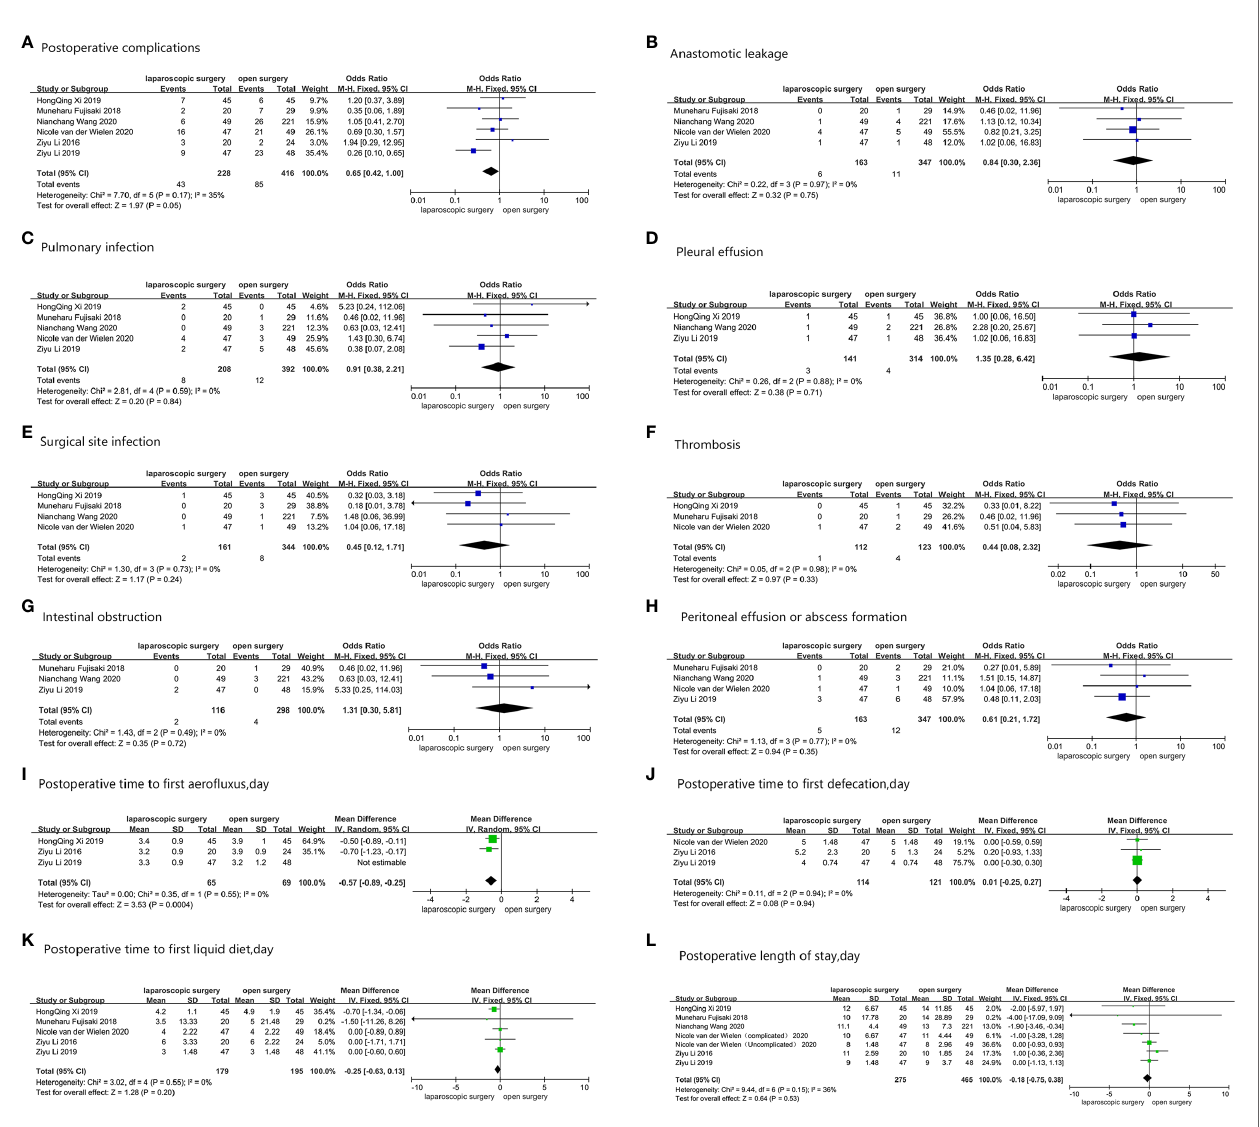
FIGURE 3 | Postoperative short-term clinical outcomes: (A) Postoperative complications; (B) Anastomotic leakage; (C) Pulmonary infection; (D) Pleural effusion; (E) Surgical site infection; (F) Thrombosis; (G) Intestinal obstruction; (H) Peritoneal effusion or abscess formation; (I) Postoperative time to fi rst aero fl uxus, day; (J) Postoperative time to fi rst defecation, day; (K) Postoperative time to fi rst liquid diet, day; (L) Postoperative length of stay,